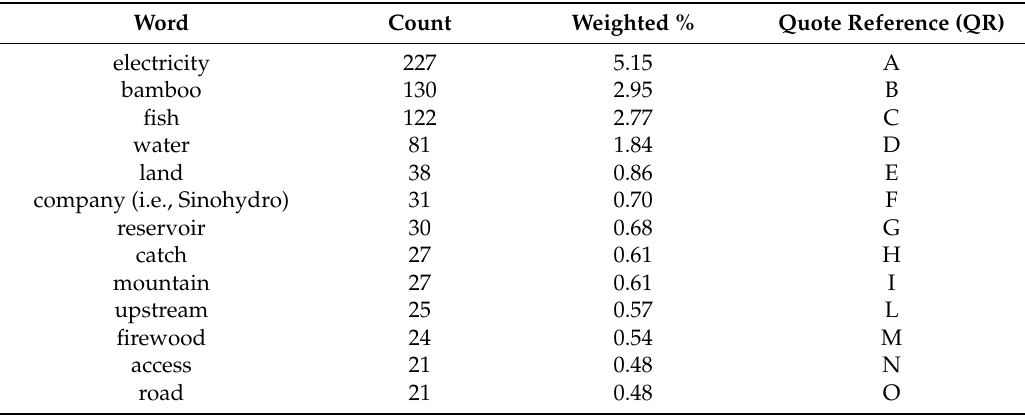
Table 4. Word frequency analysis for access to